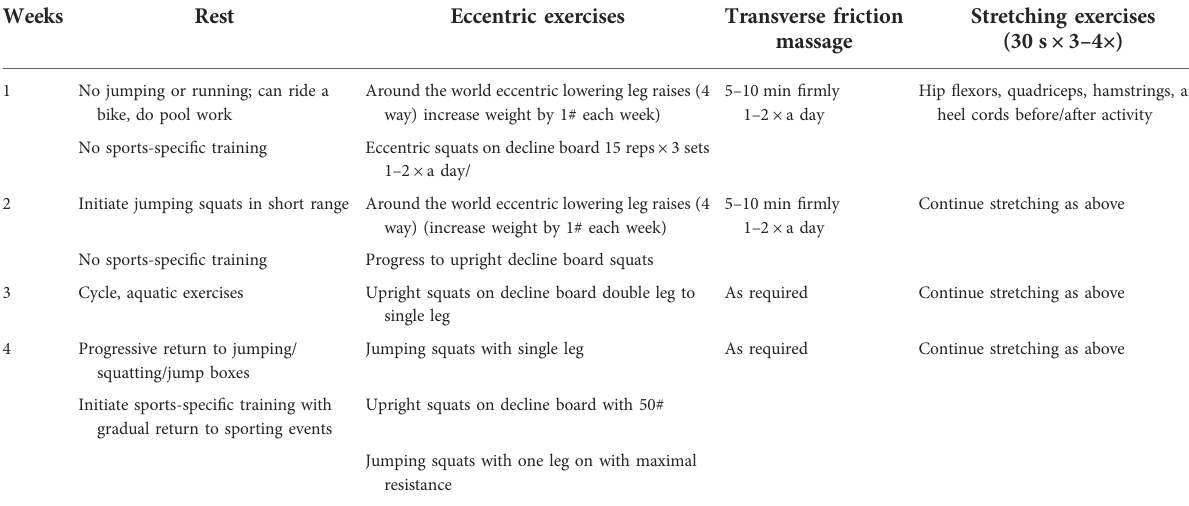
TABLE 1 Rehabilitation exercises for patellar